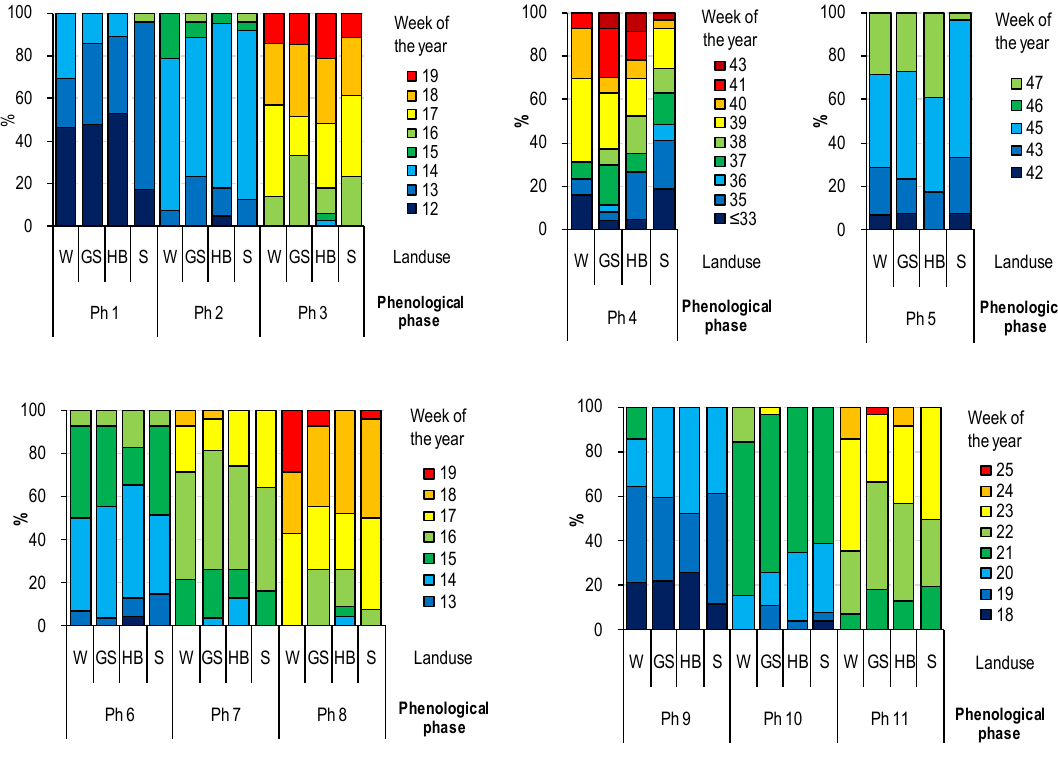
Figure 4. The frequency of occurrence of selected phenological phases (Ph1–Ph11) depending on the type of land use (BBCH code see Table 3).